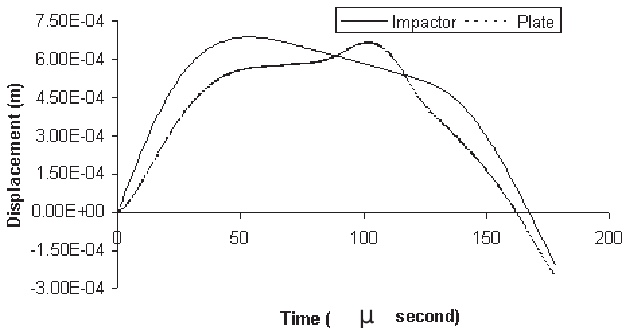
Fig. 8. The impactor displacement and the plate center displacement corresponding to Mesh